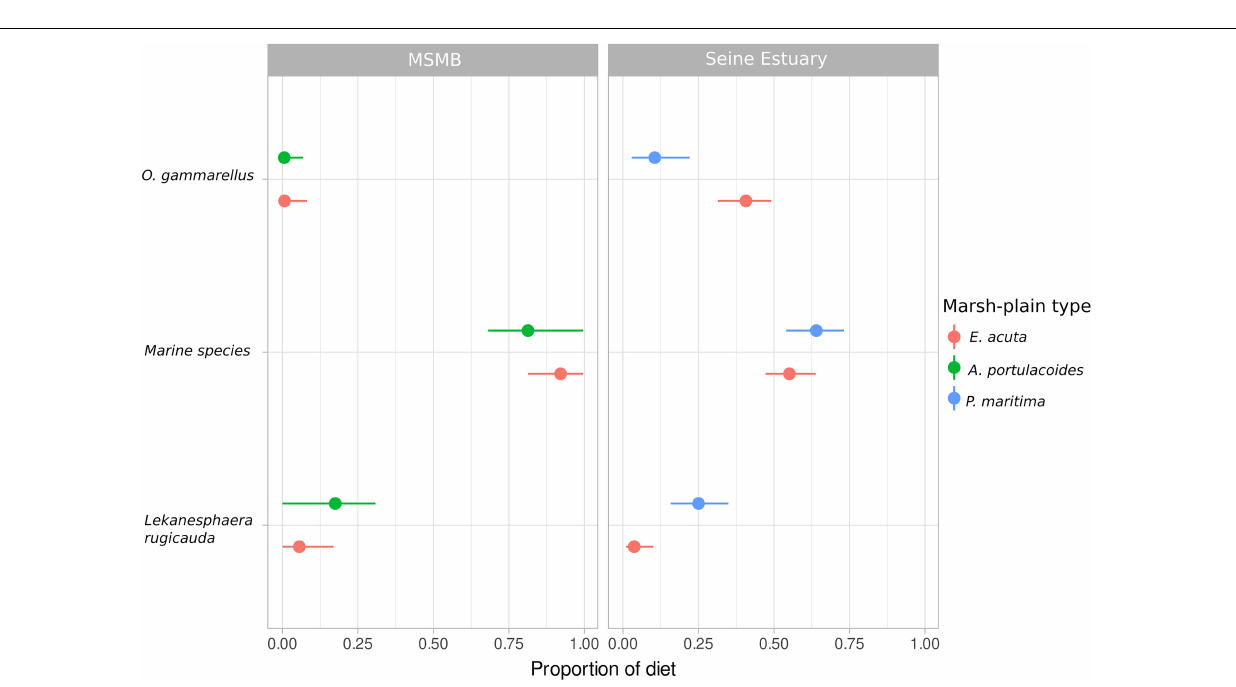
FIGURE 3 | Posterior median (points) with 90% (horizontal lines) confidence intervals for contribution of each primary producer (MPB, microphytobenthos; POM, particulate organic matter; Terr. pla., terrestrial vegetation) according to marsh-plain type in the sampling area for D. labrax . MSMB, Mont-Saint-Michel Bay.